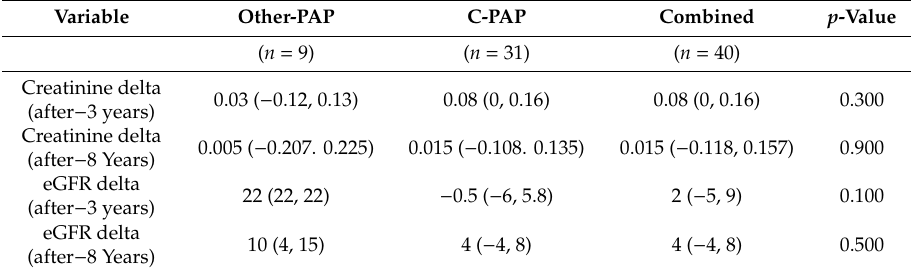
Table 2. Descriptive table of outcome variations accordingly to the intervention